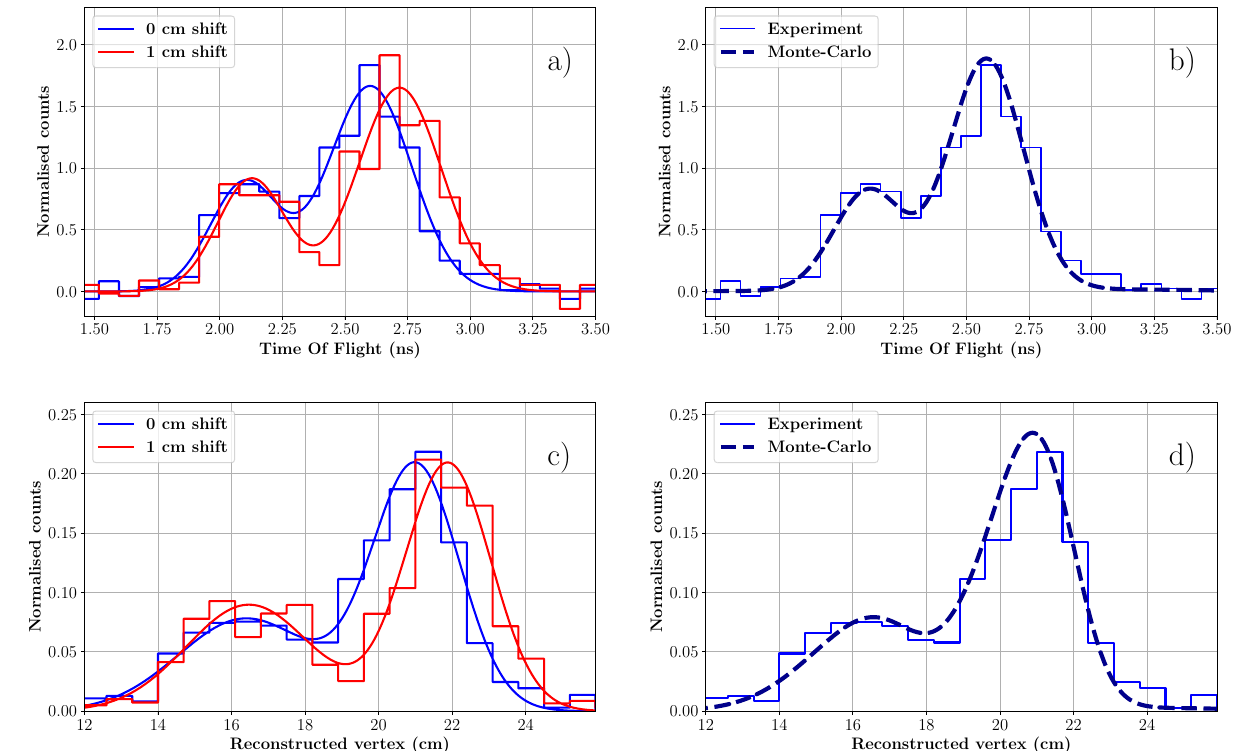
Figure 5. PGT profiles (top) and PGTI reconstructed profiles (bottom) obtained from the PMMA targets described in Fig. 1 irradiated with 63 MeV protons. In ( a ) the experimental TOF profile obtained for the reference geometry (in blue) is compared to the one obtained after engendering a proton range shift of 1 cm (in red). The two histograms are fitted with a double gaussian fuction to improve readability; the fit was not used for analysis. In ( b ), the simulated reference profile (dashed line) is compared to the corresponding experimental data. In ( c ) the two profiles shown in ( a ) are reconstructed with the PGTI algorithm to convert them into the space domain. In ( d ) the reconstructed simulated (dashed line) and experimental (continuous line) reference profiles, corresponding to data in figure ( b ) are presented. The experimental profiles are obtained with a PG module composed of a 1 cm 3 PbF 2 crystal coupled to a 3 3 mm 2 SiPM and placed at 90 ◦ respect to the beam. × For the simulation of the reference profile, we used the Geant4.10.4.p02 toolkit with the QGSP-BIC-EMY physics list and the UNIFIED